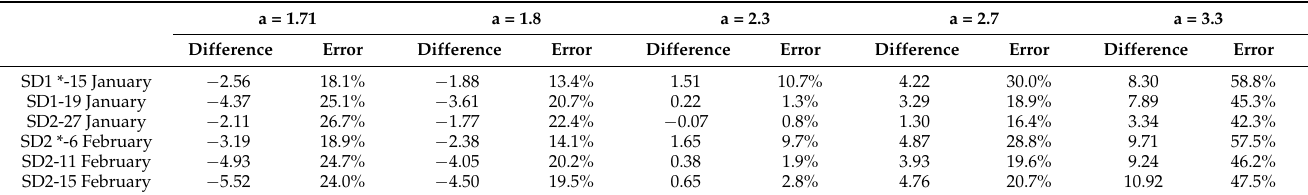
Table 1. Simulation error at different growth